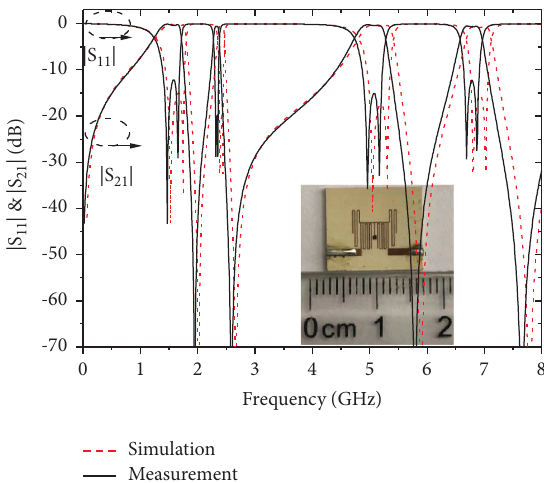
Figure 9: Simulated and measured results of quad-band BPF.